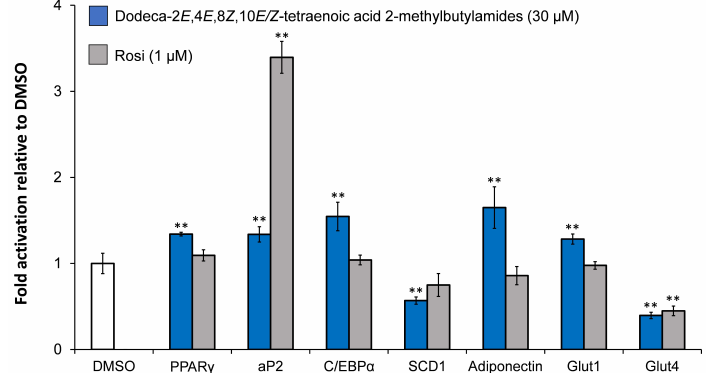
Figure 6. Effect of dodeca-2 E ,4 E ,8 Z ,10 E / Z -tetraenoic acid 2-methylbutylamides (30 µ M) on gene expression of proteins involved in adipogenesis (PPAR γ , C/EBP α , aP2), glucose transport (Glut1, Glut4), lipogenesis (SCD1), and adipokines (adiponectin) in mature 3T3-L1 cells. Rosi (1 µ M) was the positive control. All values are normalized to the vehicle DMSO and are expressed as a mean ± SD of three independent experiments in triplicates. ** p < 0.001 indicates significance relative to